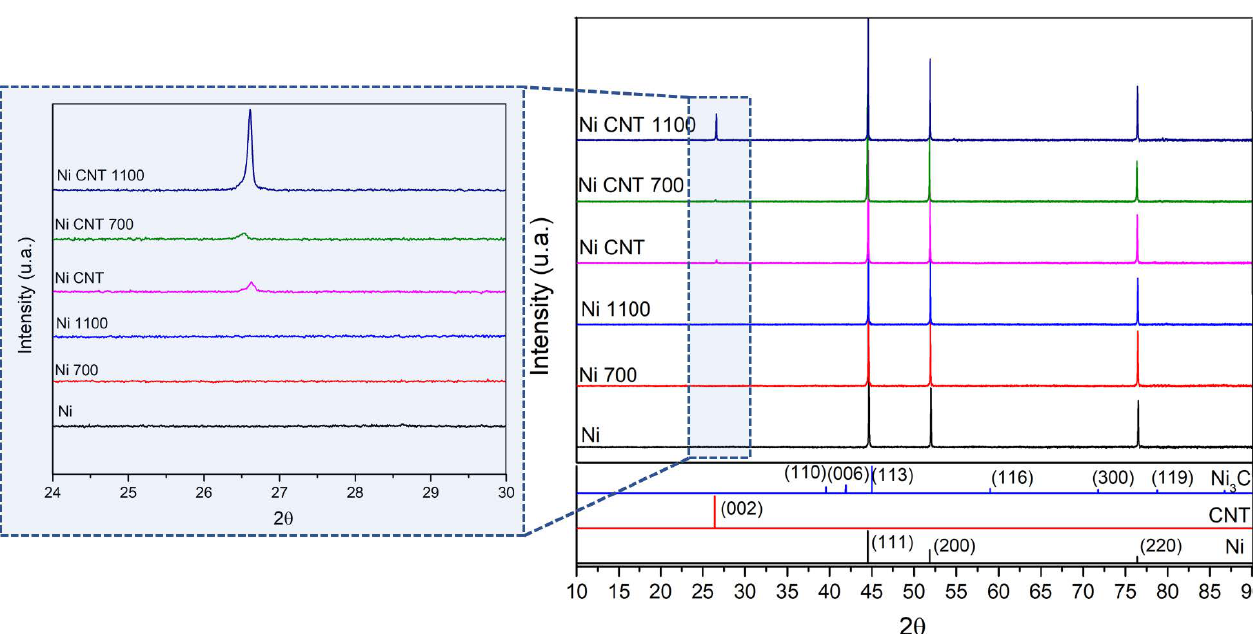
Figure 10. XRD patterns of Ni and Ni-CNT nanocomposite as-sintered and heat-treated at 700 °C for 120 min and 1100 °C for 30 min and XRD peaks for Ni, C, and Ni 3 C phases.